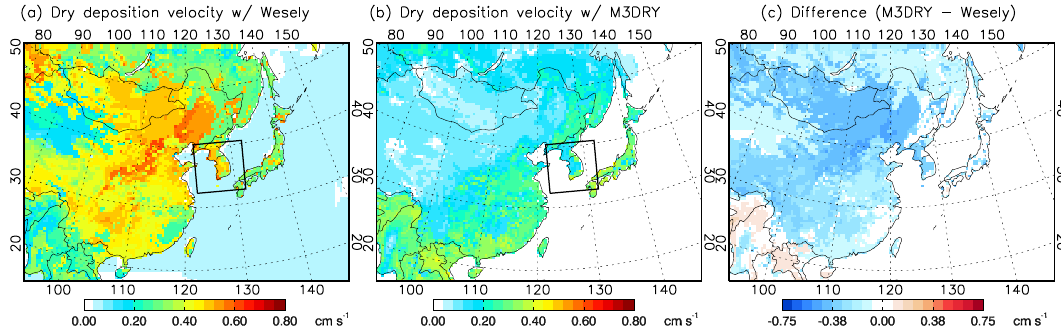
Figure 1. Monthly mean O 3 dry deposition velocities in East Asia for May 2004 from WRF-Chem using the Wesely scheme (left) and the M3DRY scheme (middle). The differences between the two simulations are shown in the right